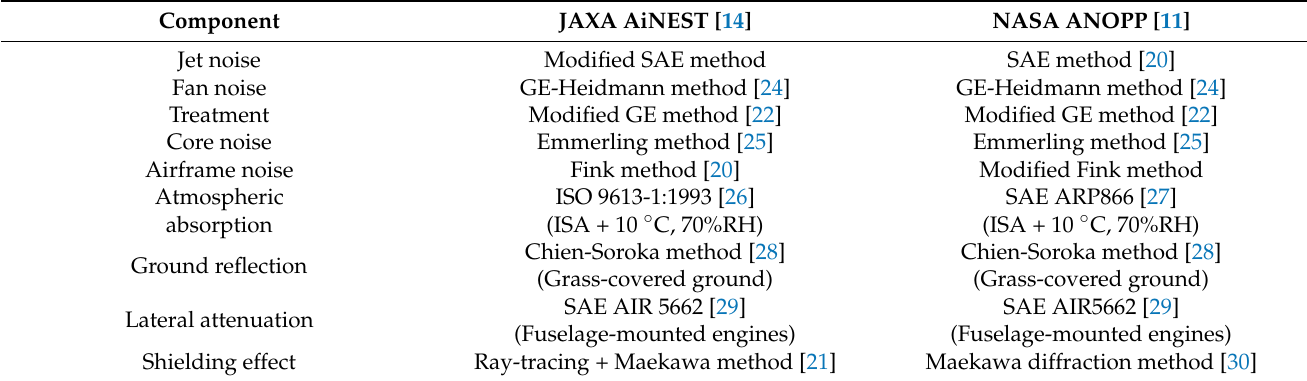
Table 2. Noise source models and propagation models.